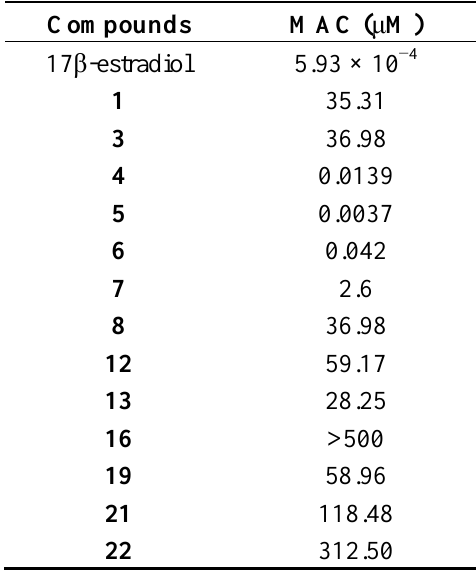
Table 3. Estrogenic activity of F. macrophylla isolated